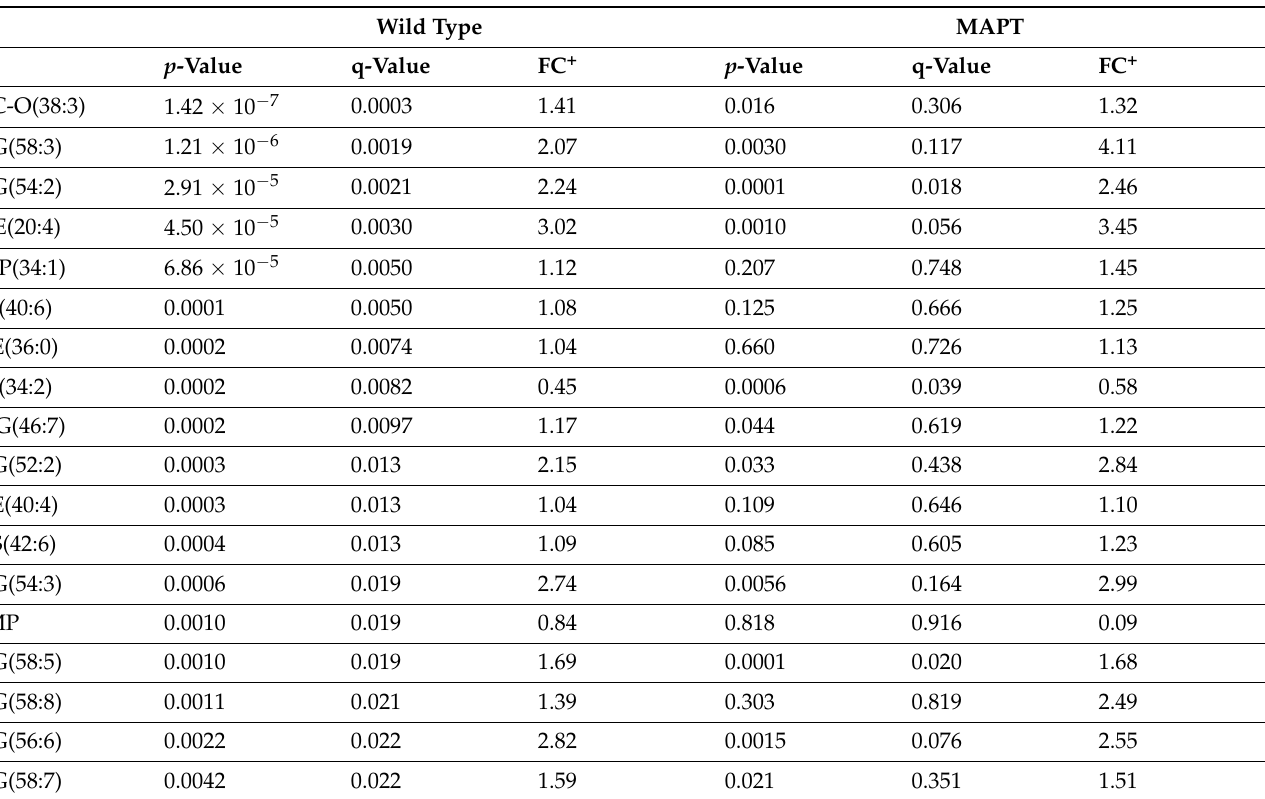
Table 2. Annotated metabolites associated with tunicamycin treatment in both wild type and MAPT mutant dopamine neurons.